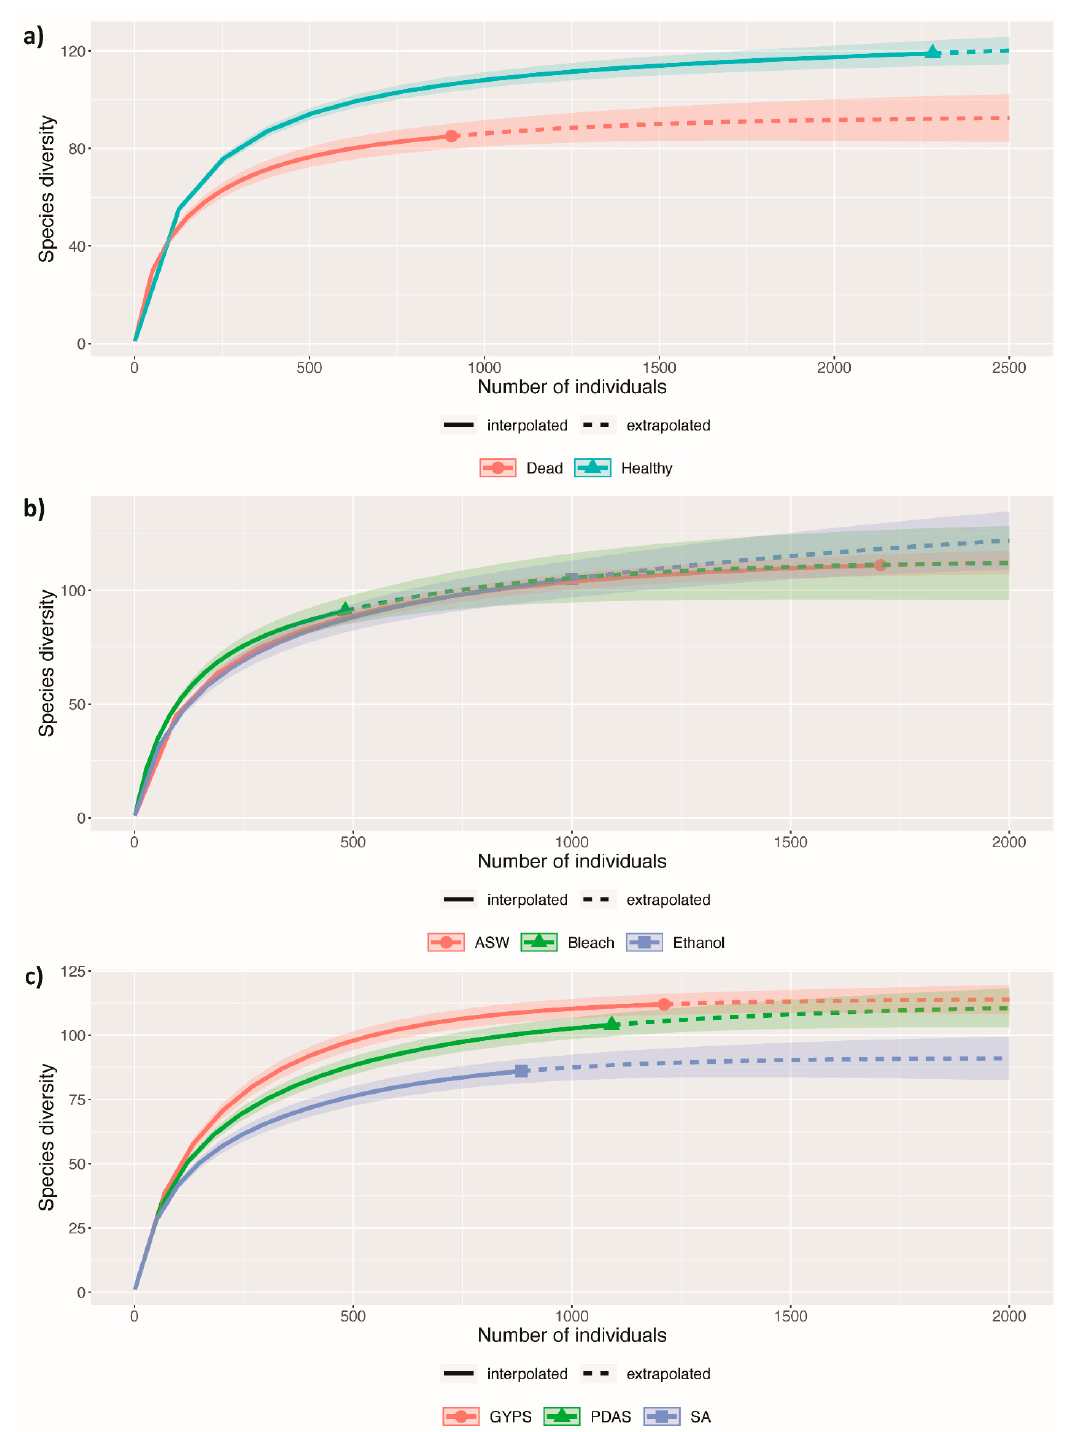
Figure 3. Sample-size-based rarefaction and extrapolation curves of fungal diversity from Pterocladiella capillacea for the Hill number ( q = 0) for each of the different isolation conditions as following ( a ) healthy and dead thalli; ( b ) thalli surface sterilized/washed by artificial seawater (ASW), 70% ethanol (Ethanol), and 4% sodium hypochlorite (Bleach); and ( c ) thalli plated on seawater agar (SA), glucose-yeast extract-peptone seawater agar (GYPS), and potato dextrose seawater agar (PDAS). The 95% confidence intervals were obtained by a bootstrap method based on 50 replicates.